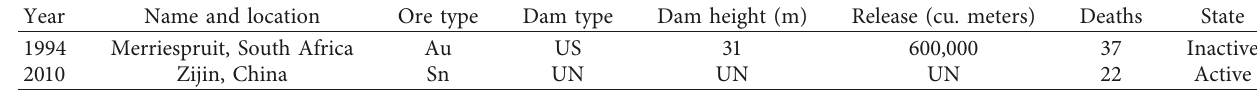
Table 4: Example of tailings dam failure caused by overtopping.